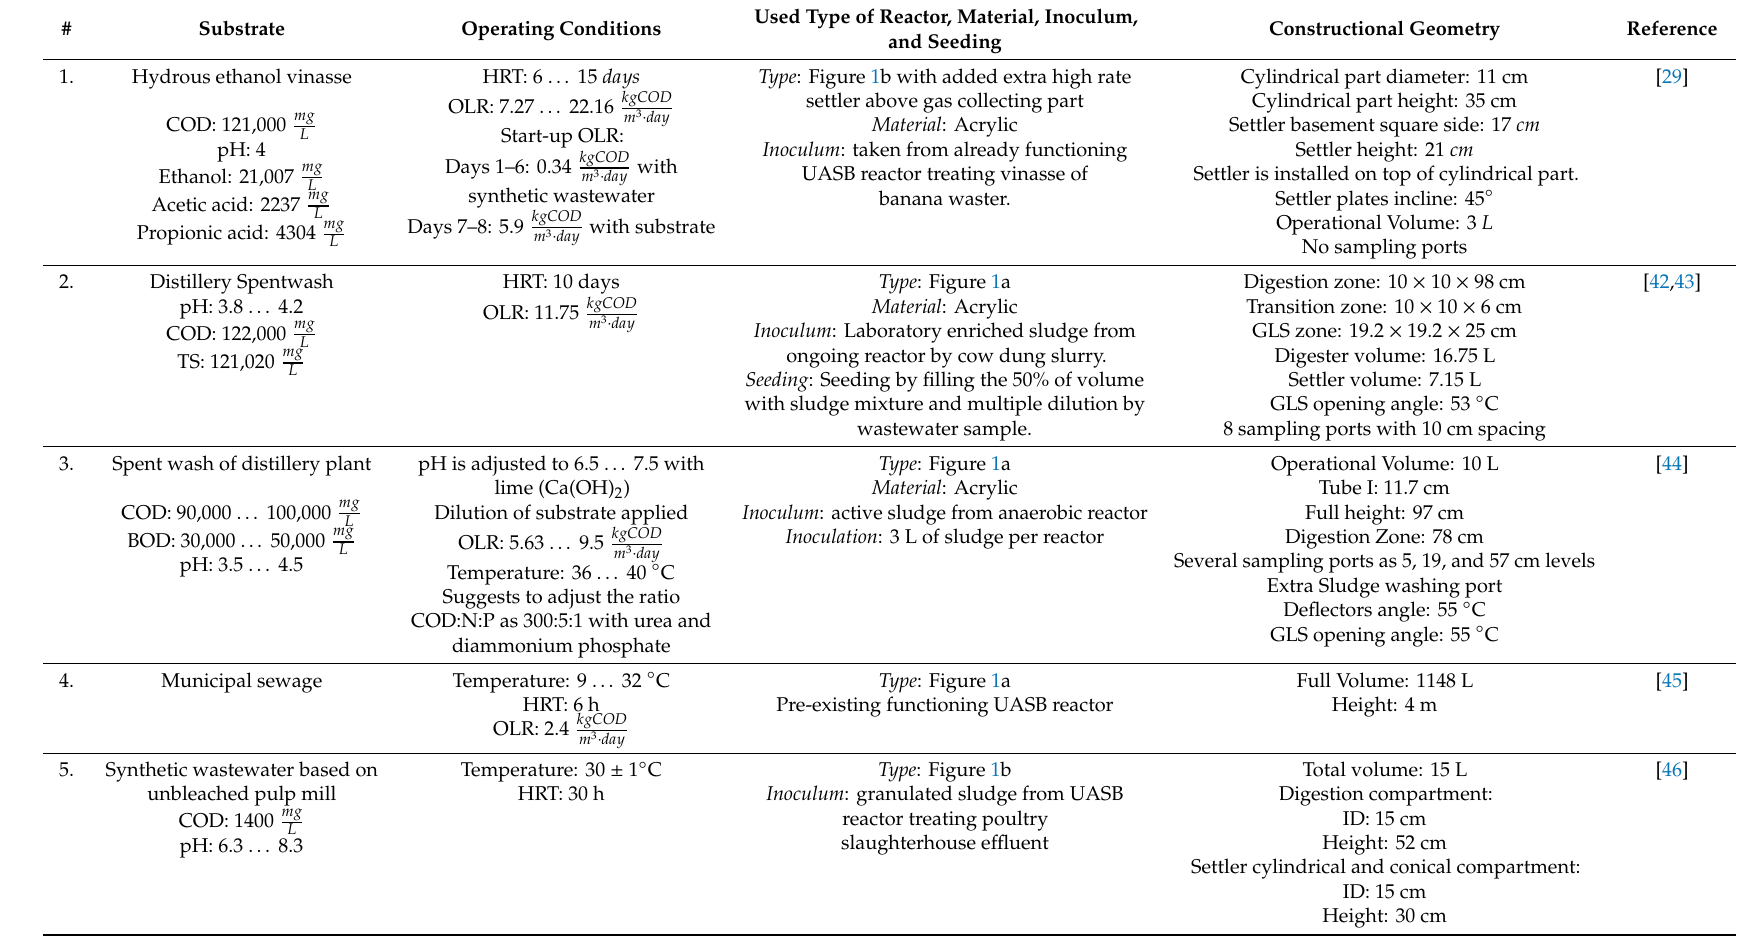
Table 2. Overview of available information of UASB reactors used in laboratory